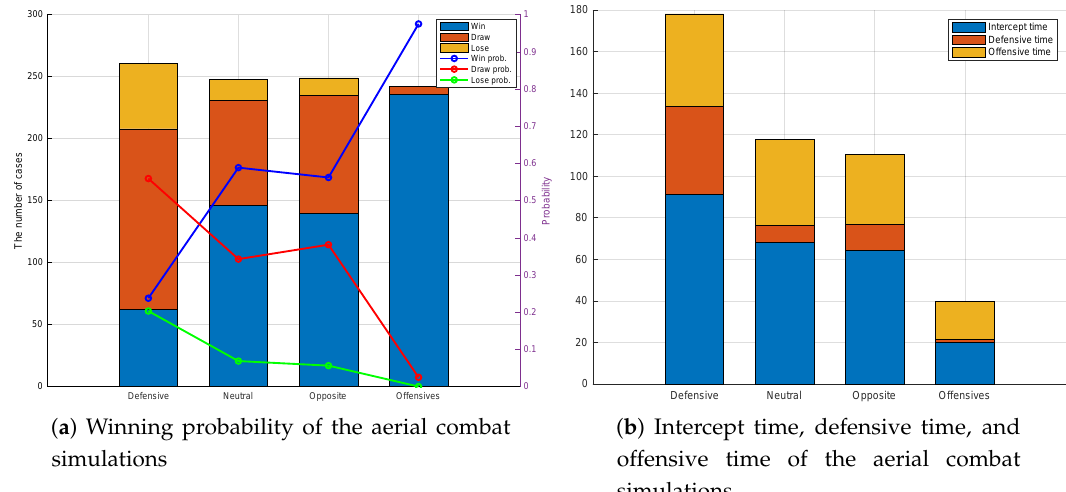
Figure 12. The results of the 1000 times aerial combat